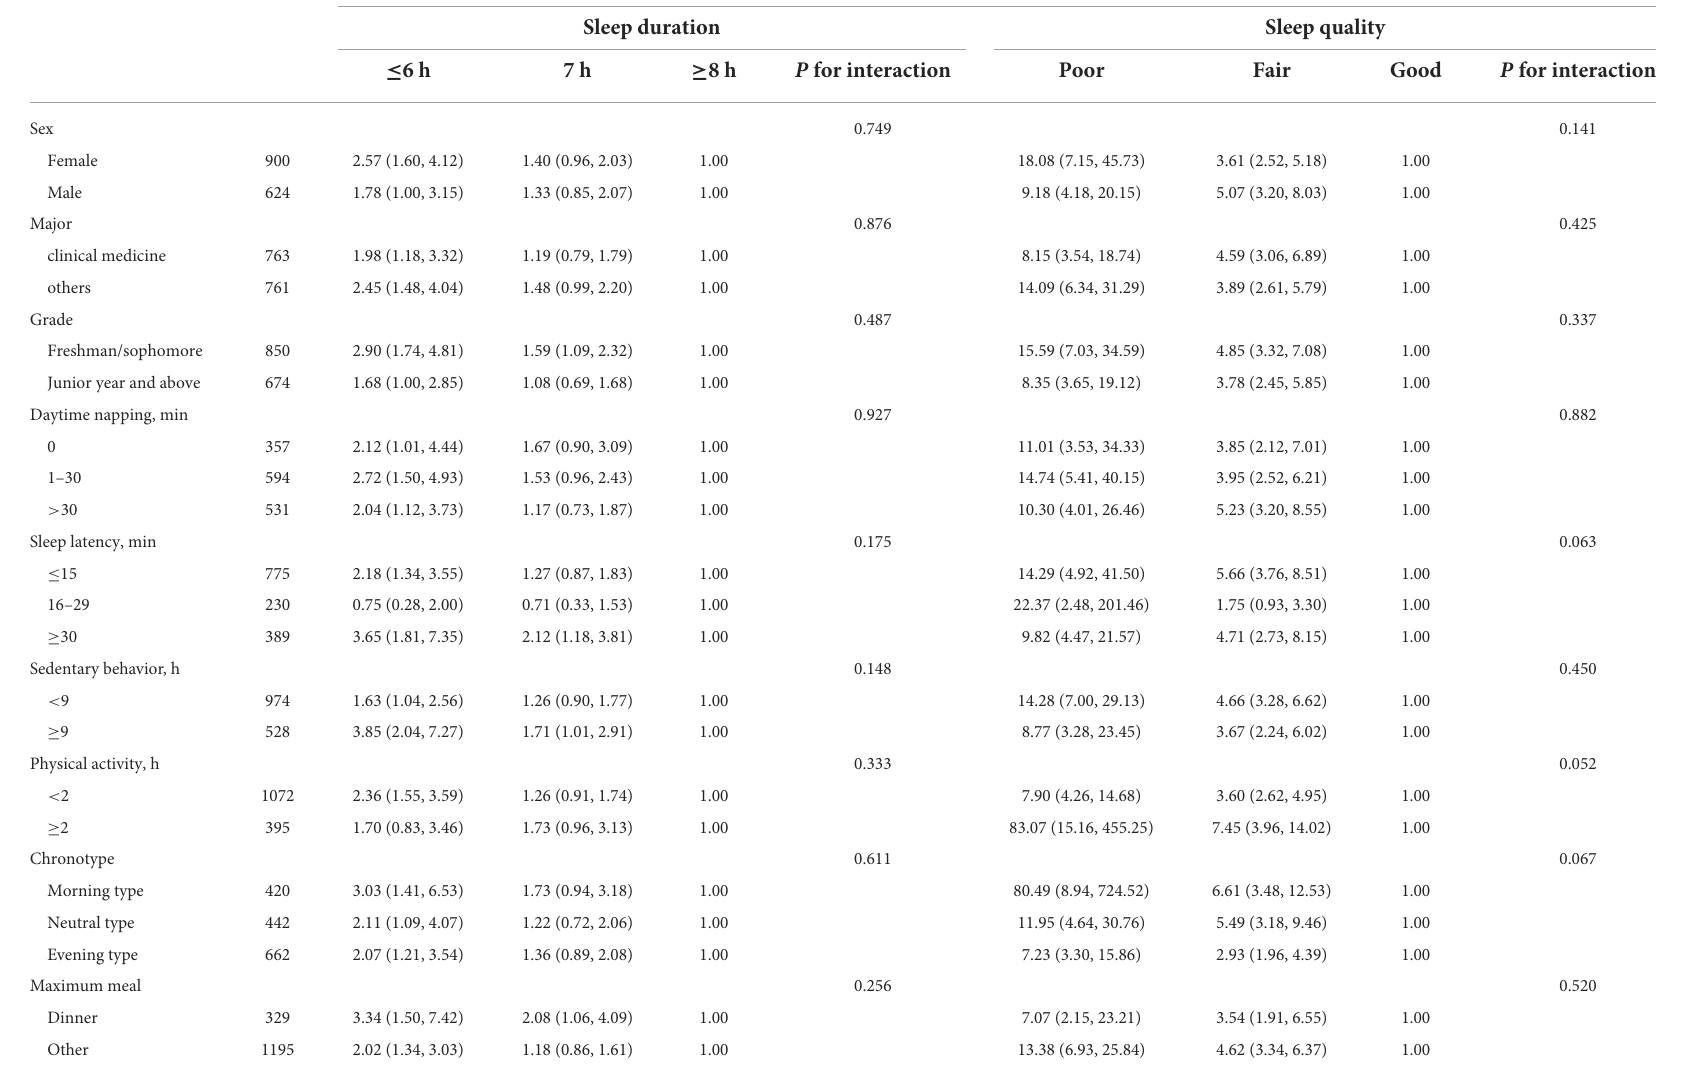
TABLE 3 Association of suboptimal SRH with sleep duration and sleep quality, stratification analyses.